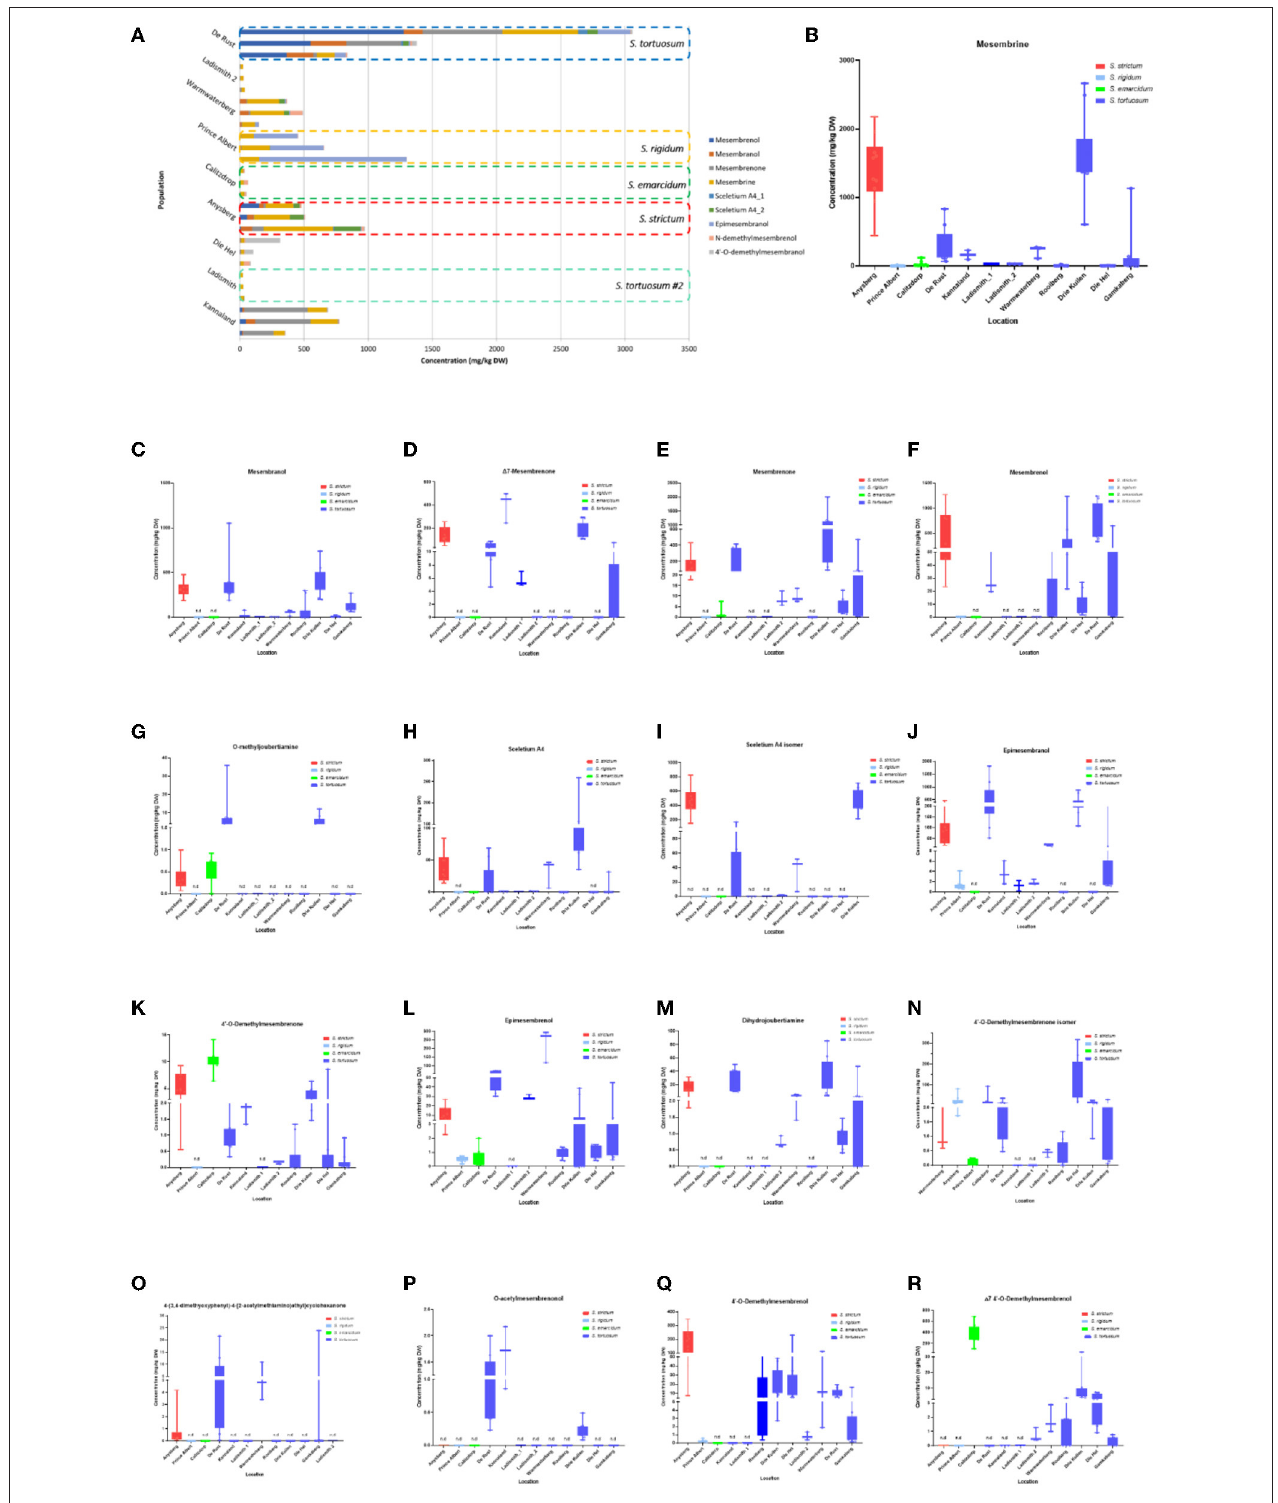
FIGURE 5 | (A) Concentration of Sceletium metabolites in different species and populations found at twelve locations. Horizontal stacked columns represent metabolites (mg/kg DW) tentatively identified chemical markers responsible for metabolomic separations. Each horizontal stacked column represents up to